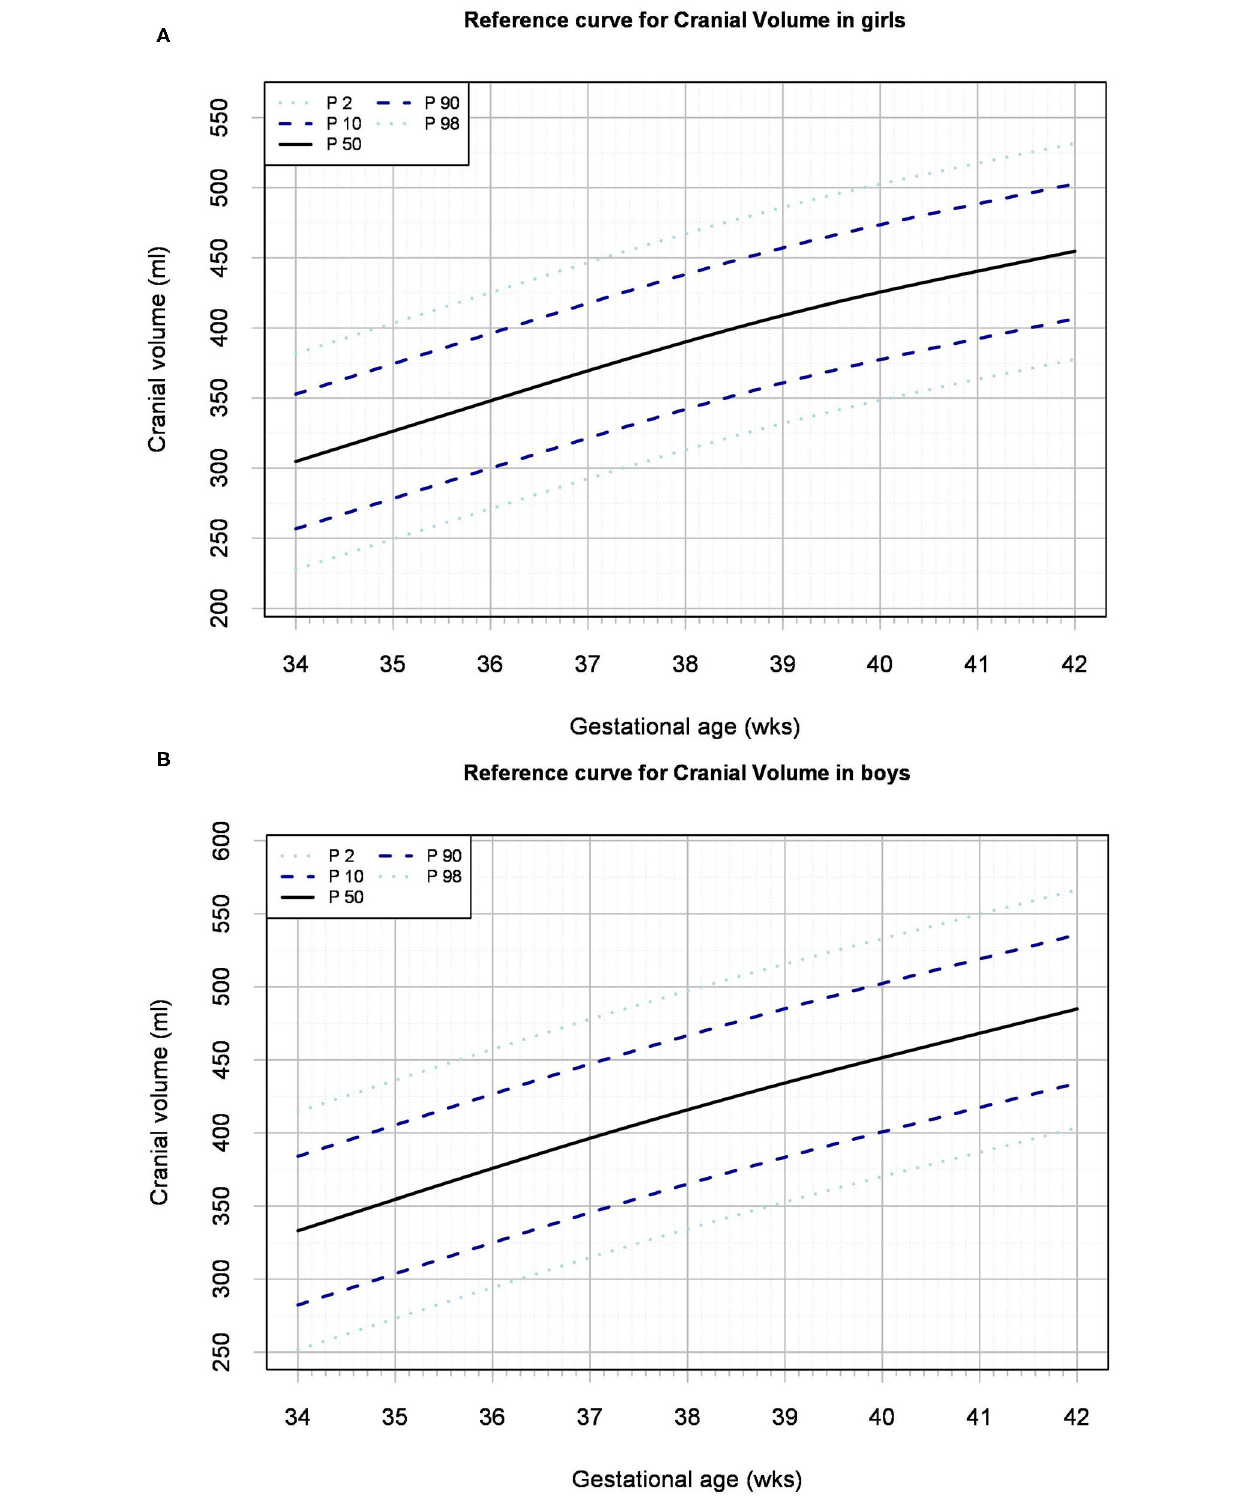
FIGURE 1 | Reference curve for cranial volume by gestational age for girls (A) and boys (B) .